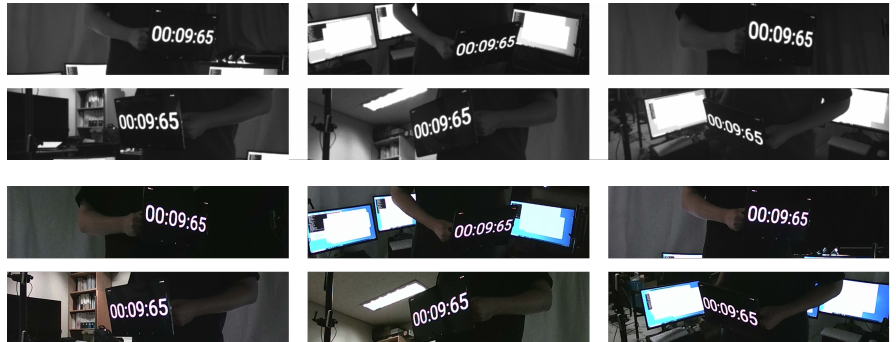
Figure 11. Qualitative evaluation of the RealSense GenLock synchronization.